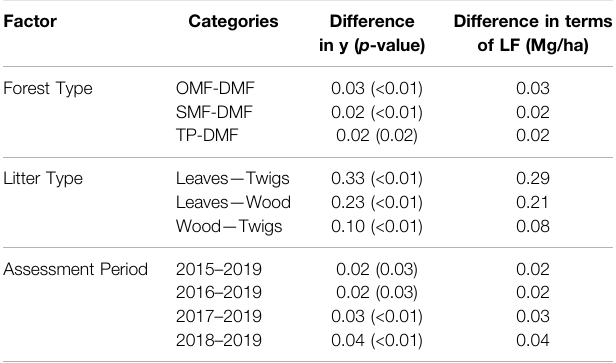
TABLE 3 | Signi fi cant Differences Obtained in Post-Hoc Tests for sustainable